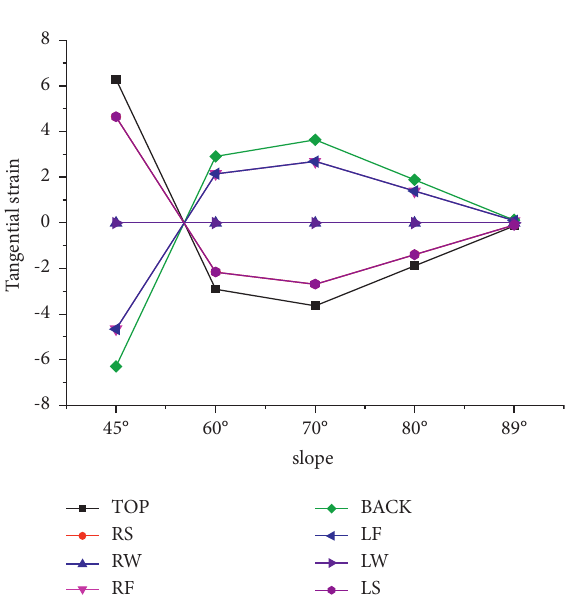
Figure 6: The influence of mountain slope.